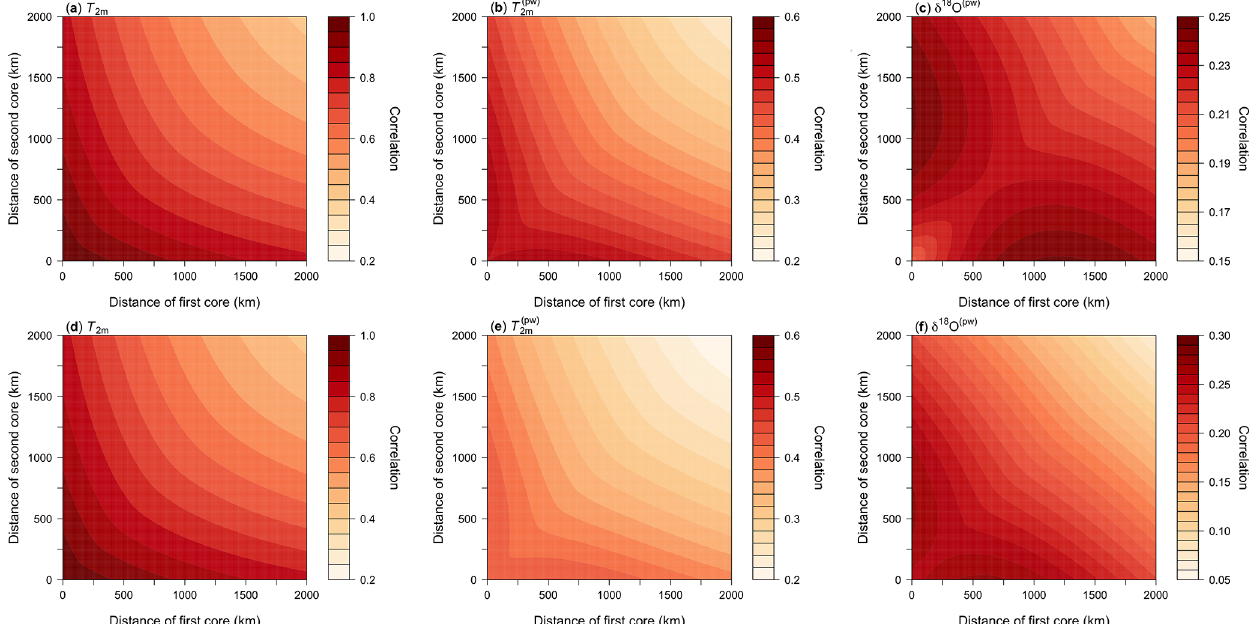
Figure A2. Two-dimensional sampling correlation structures with temperature as predicted from our conceptual model using the model parameters from the DML ( a – c ) and Vostok ( d – f ) regions. Shown is the mean correlation of all possible single correlations for the average of two time series sampled from a pair of concentric rings around the target site for the fields of ( a , d ) T 2m , ( b , e ) T (pw) Note that panels ( a ) and ( d ) are based on the same parameters and therefore